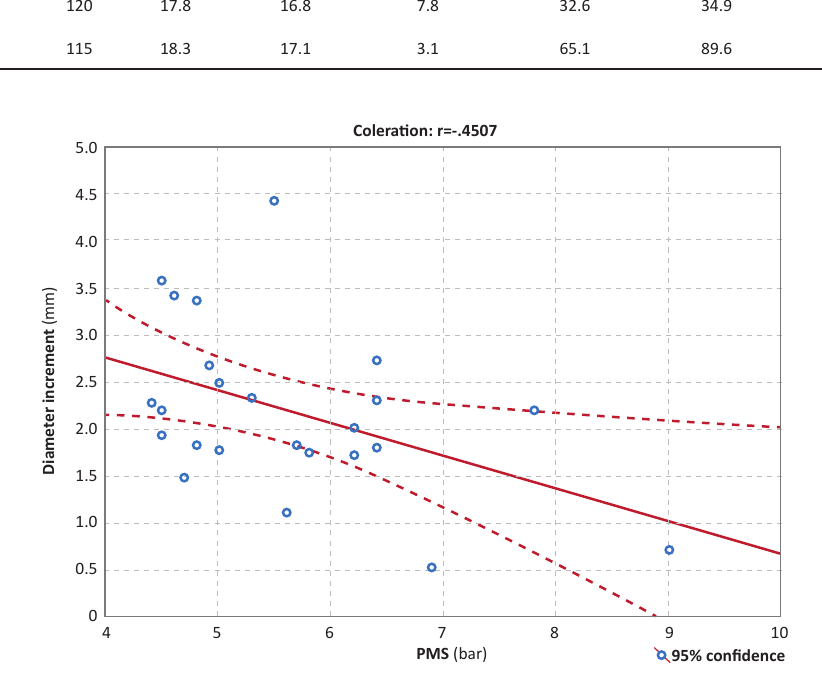
FiGure1. Correlations between diameter increment (mm) of container seedlings of narrow-leaved ash under conditions of substrate saturation and water potential (bar) on 16 July